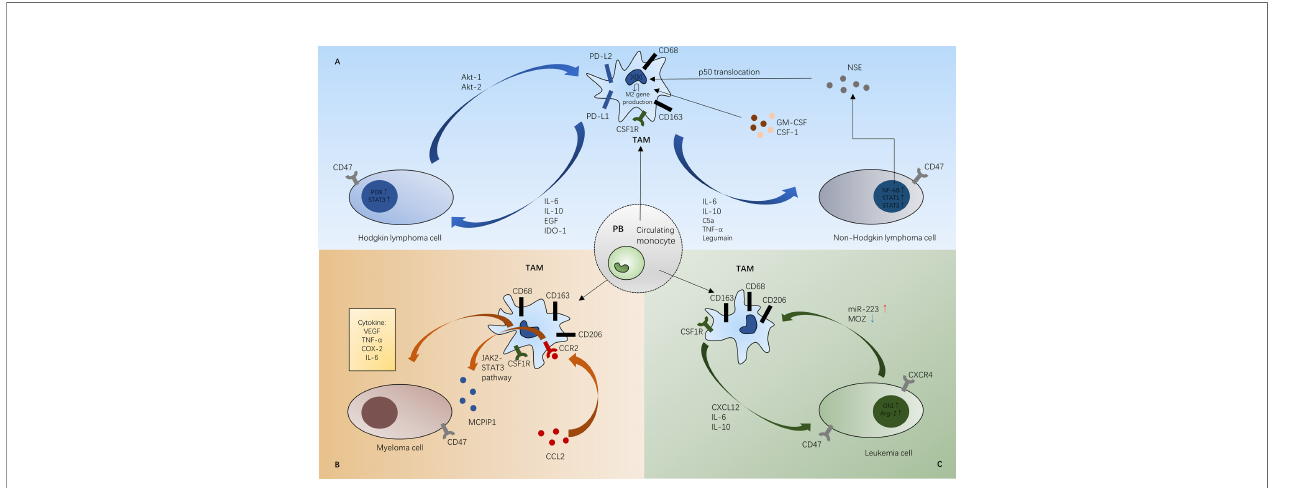
FIGURE 2 | Schematic representations of mechanisms between TAMs and tumor cells in Hodgkin lymphoma and non-Hodgkin lymphoma (A) , myeloma (B) , and leukemia (C) . In the different tumor microenvironment, TAMs in fi ltrate different tumor tissue to promote tumor growth. (A) In Hodgkin lymphoma, TAMs can activate HL cell proliferation through the STAT3 pathway and PI3K-Akt pathway. Besides, M1 macrophage polarization can be predominated by the NF- k B and STAT1 pathways in non- Hodgkin lymphoma. (B) CCL2 induces MCPIP1 expression via the JAK2-STAT3 signaling pathway in the MM bone marrow microenvironment. TAMs can also secrete proangiogenic cytokines like VEGF in MM microenvironment. (C) In the leukemia microenvironment, CSF-1R signaling paves the way for TAM recruitment. G fi 1 polarizes M1 phenotype macrophages into M2 macrophages to suppress the immune system and MOZ is a direct target of miR-223 promoting monocyte-to-macrophage development and M1 polarization. STAT3, signal transducer and activator of transcription; EGF, epidermal growth factor; IDO-1, indoleamine 2,3-dioxygenase; CSF1R, colony-stimulating factor receptor; CSF-1, colony-stimulating factor-1; GM-CSF, granulocyte macrophage-colony stimulating factor; TNF- a , tumor necrosis factor- a ; NSE, neuron-speci fi c enolase; VEGF, vascular endothelial growth factor; COX-2, cyclooxygenase-2; MOZ, monocytic leukemia zinc- fi nger; G fi 1, growth factor independent 1; Arg-2, arginase-1; PB, peripheral blood; TAM, tumor-associated